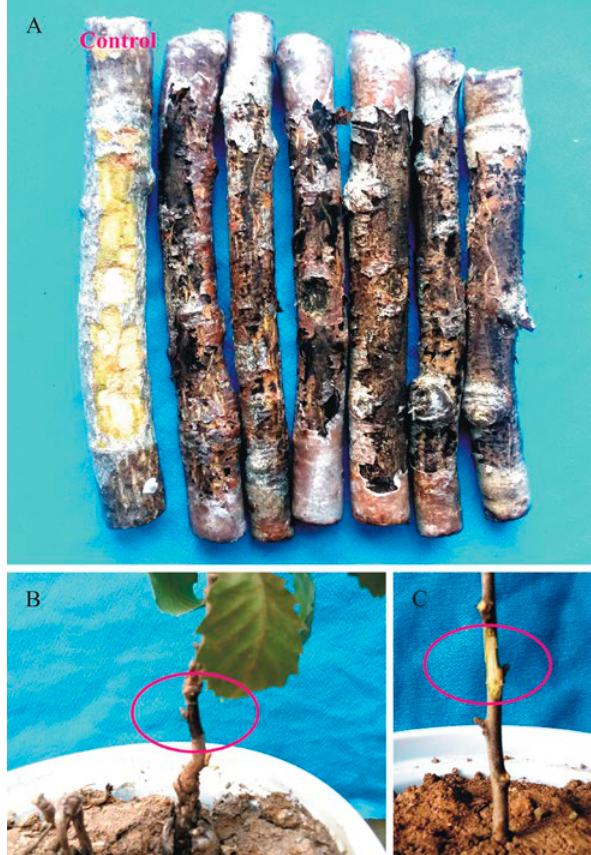
Fig.5. Results of pathogenecity tests performed by inoculating Neoscytalidium novaehollandiae isolates from declining Persian oak trees in Persian oak seedlings under laboratory and green- house conditions: A. Canker on detached stems, B. Vascular extent of necrotic tissue in an oak seedling 45 days post inoculation with Neoscytalidium novaehollandiae , C.